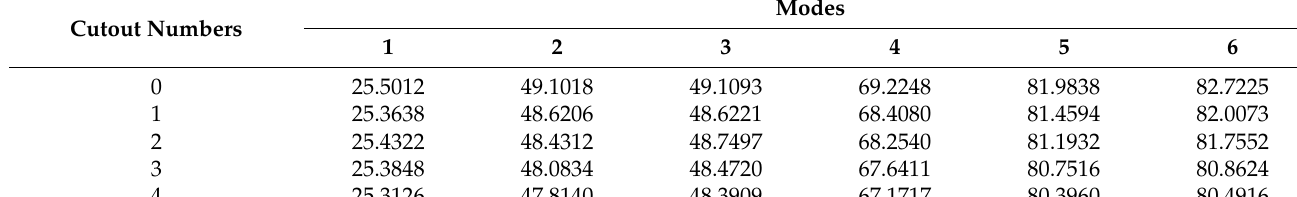
Figure 10. The displacement response for FGMs square plate with diverse cutout positions.